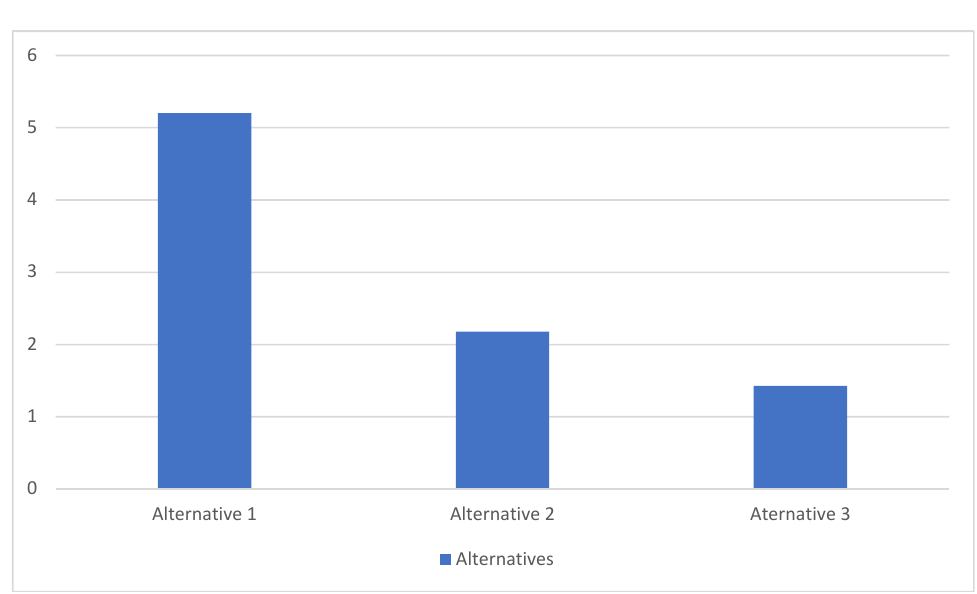
Figure 5. Payback Period Calculation Result.